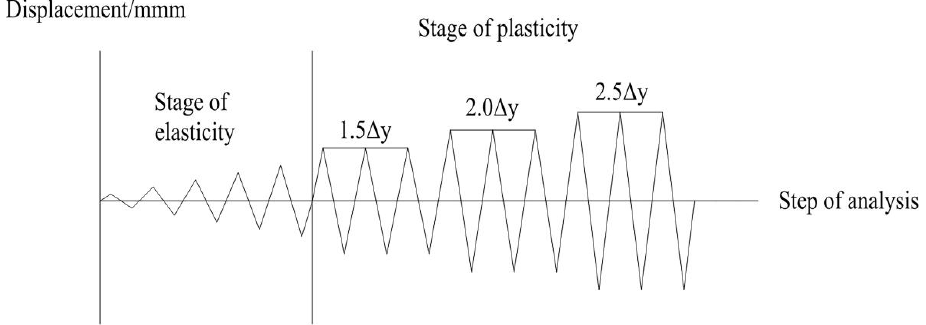
Figure 4. Plan of the quasi-static cycling